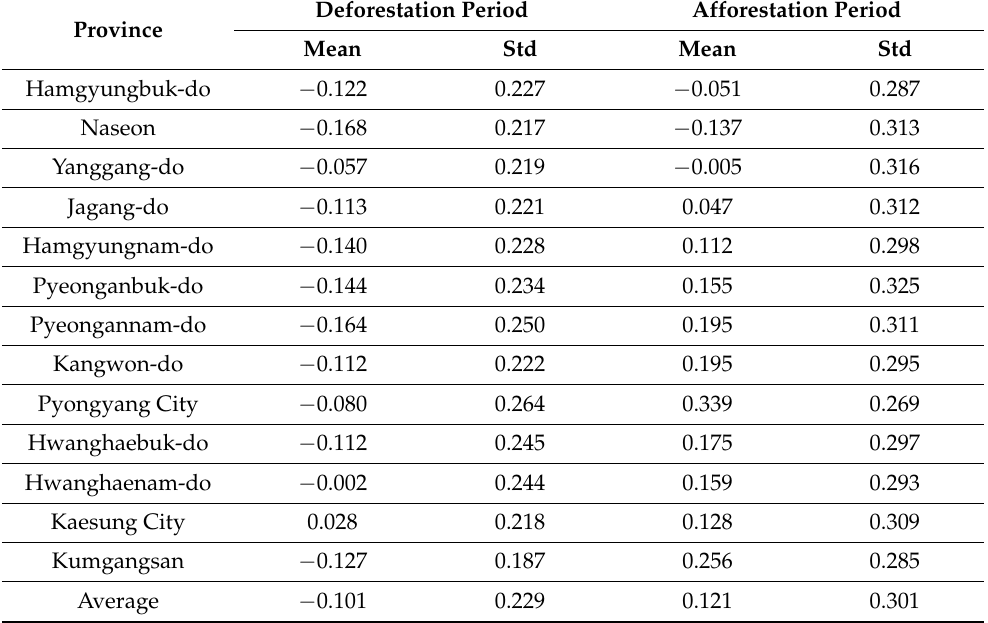
Table 1. Statistics of Theil–Sen slope on deforestation and afforestation period in each local province. Deforestation Period Afforestation Period Province Mean Std Mean Std Hamgyungbuk-do − 0.122 0.227 − 0.051 0.287 Naseon − 0.168 0.217 − 0.137 0.313 Yanggang-do − 0.057 0.219 − 0.005